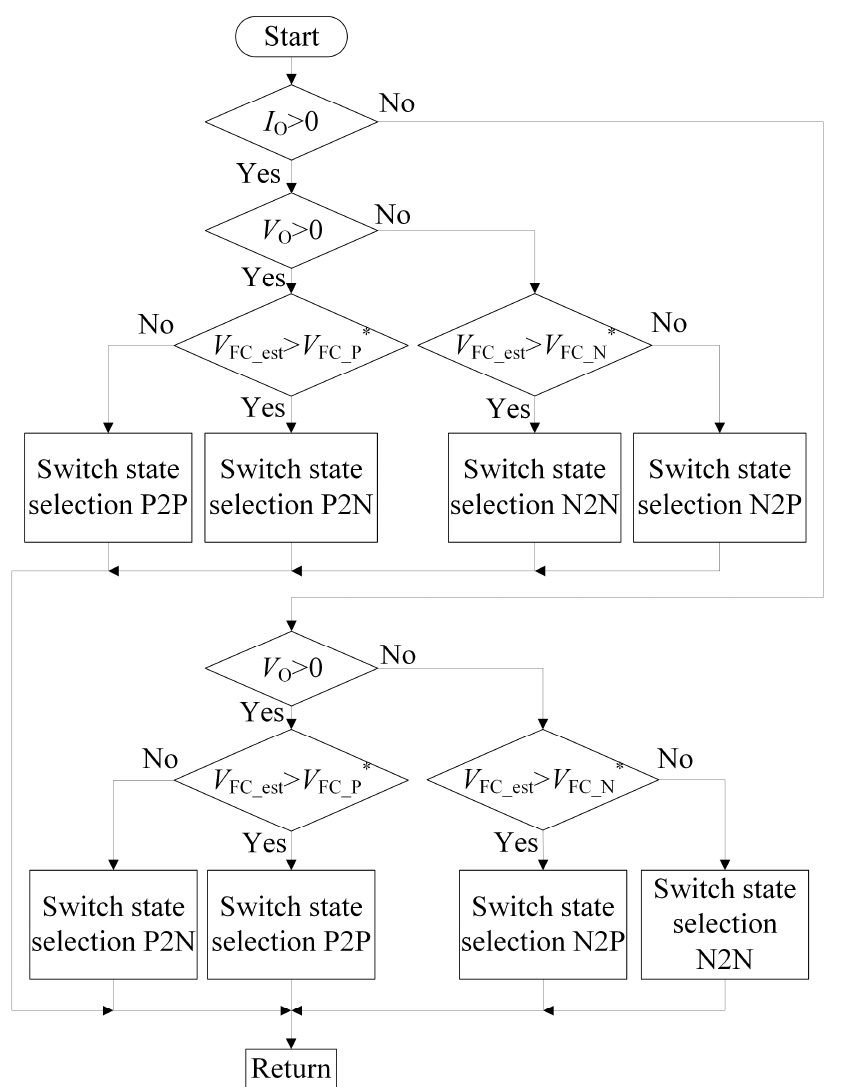
Figure 7. The flow chart of redundant switching states selection.